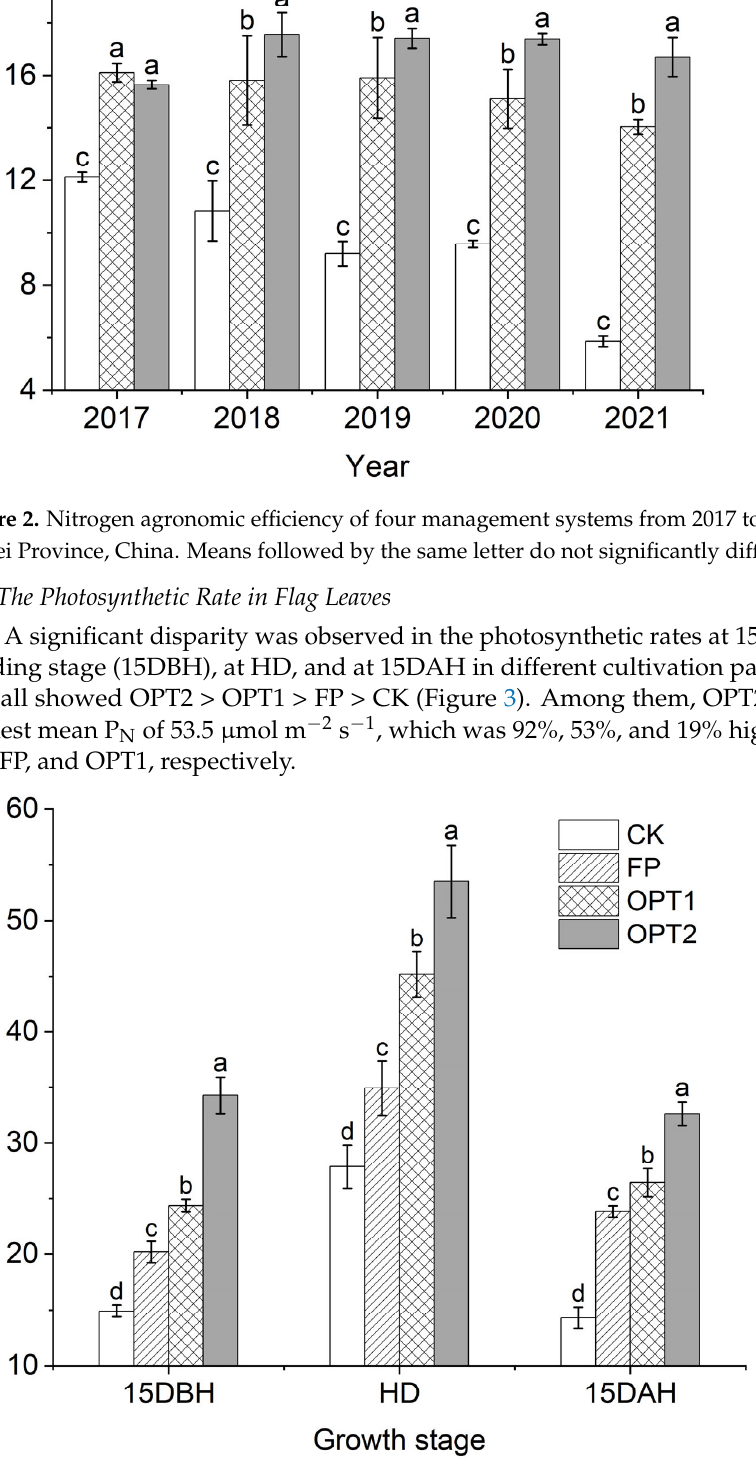
Figure 3. The photosynthetic rate of flag leaves under four management systems at 15 days before the heading stage (15DBH), heading stage (HD), and 15 days after the heading stage (15DAH). Means followed by the same letter do not significantly differ (LSD, p < 0.05). followed by the same letter do not significantly differ (LSD, p <